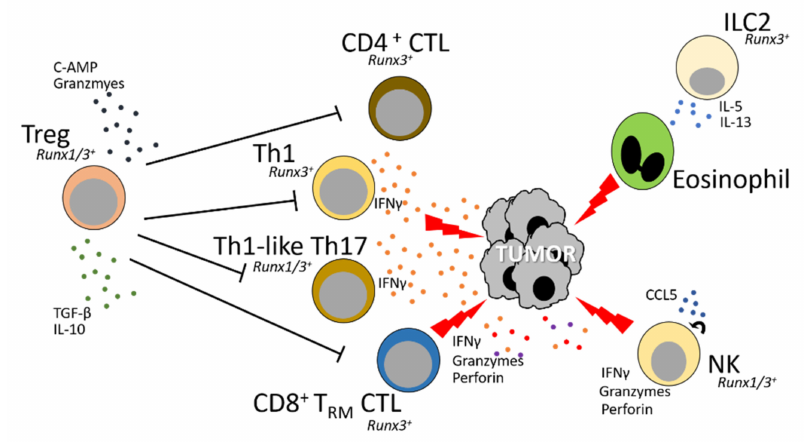
Figure 3. RUNX proteins directly regulate the function of various effector immune cells, including ILC2, NK, Th1, Th1-like Th17, CD4 + CTL, CD8 + T RM CTL and Tregs, all of which infiltrate into tumors and play important roles in anti-tumor immunity. These tumor-infiltrating lymphocytes (TILs) can have direct effects on the residency and cytolytic functions of CD4 CTL and CD8 + T RM CTL cells. Additionally, RUNX proteins can regulate anti-tumor immunity by regulating the expression